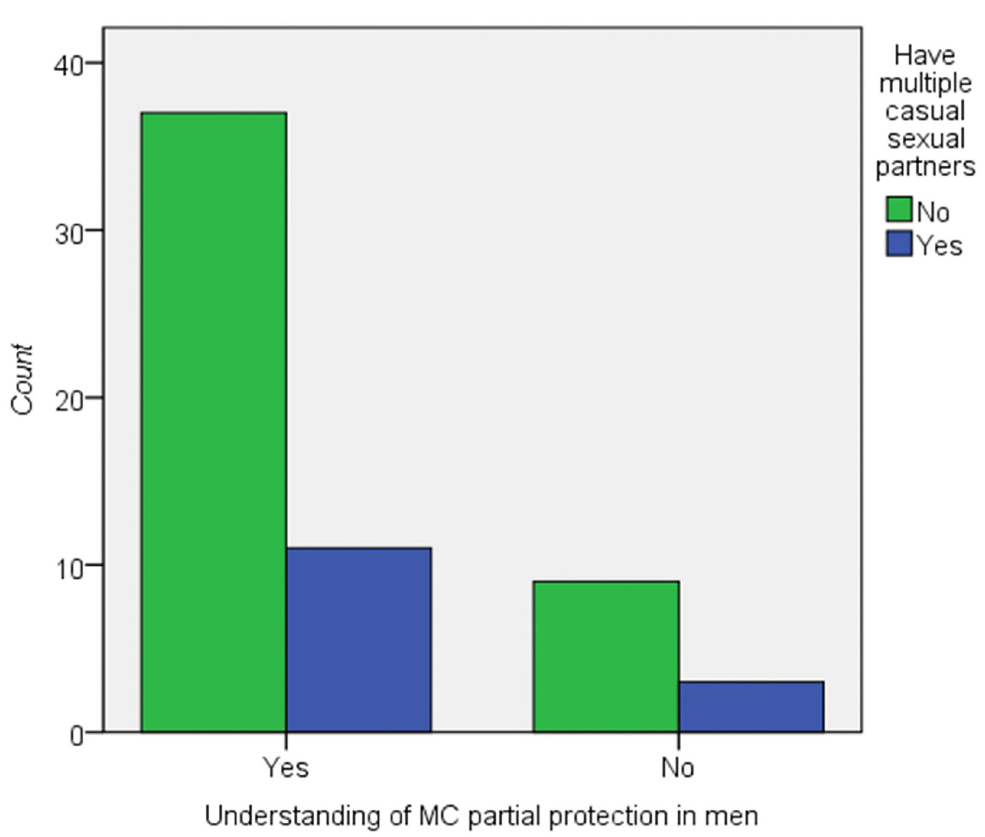
Fig 2. Relationship between understanding of MC and perceptions on having multiple casual sexual partners due to feeling of protected by MC. On Fisher’s exact test P value 0.574, p > 0.05 showing no significant association between understanding of MC and perceptions on having multiple sexual partners due to feeling of protected by